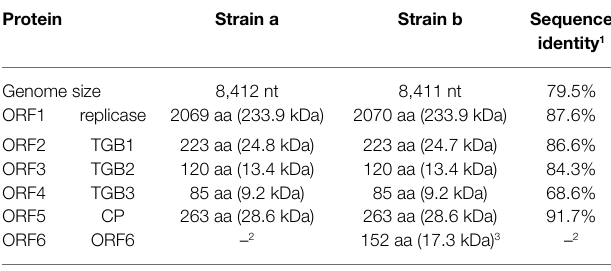
TABLE 3 | Comparison of predicted coding proteins between two WVQ